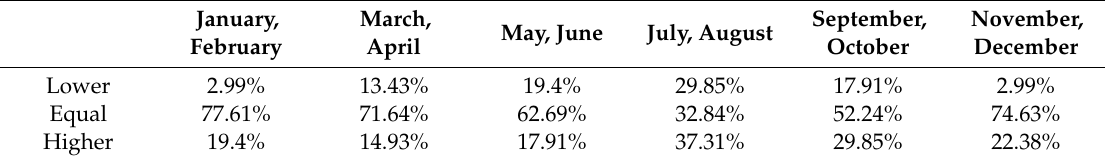
Table 7. Changes in average block ordering for blocks of the sanitation fee (before and after 2012).